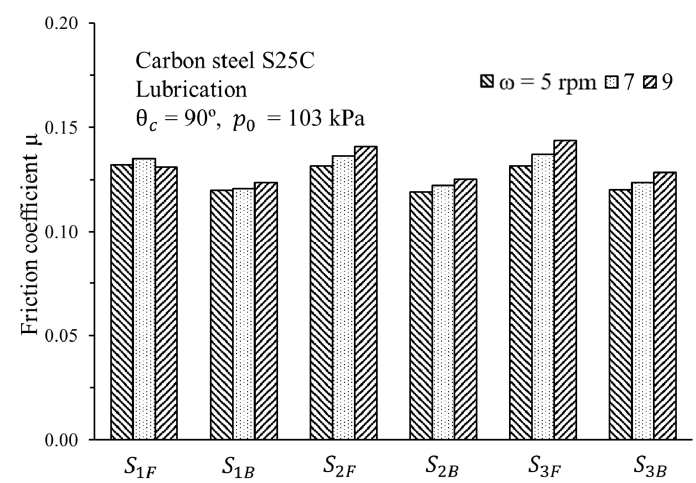
Figure 8. Effects of rotation speed on friction coefficient under lubricated condition. Figure 8. E ff ects of rotation speed on friction coe ffi cient under lubricated